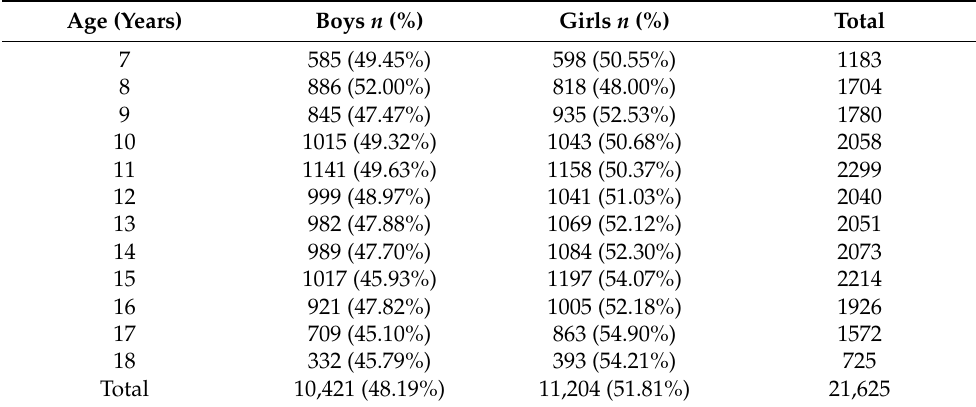
Table 1. Study population: distribution based on age and